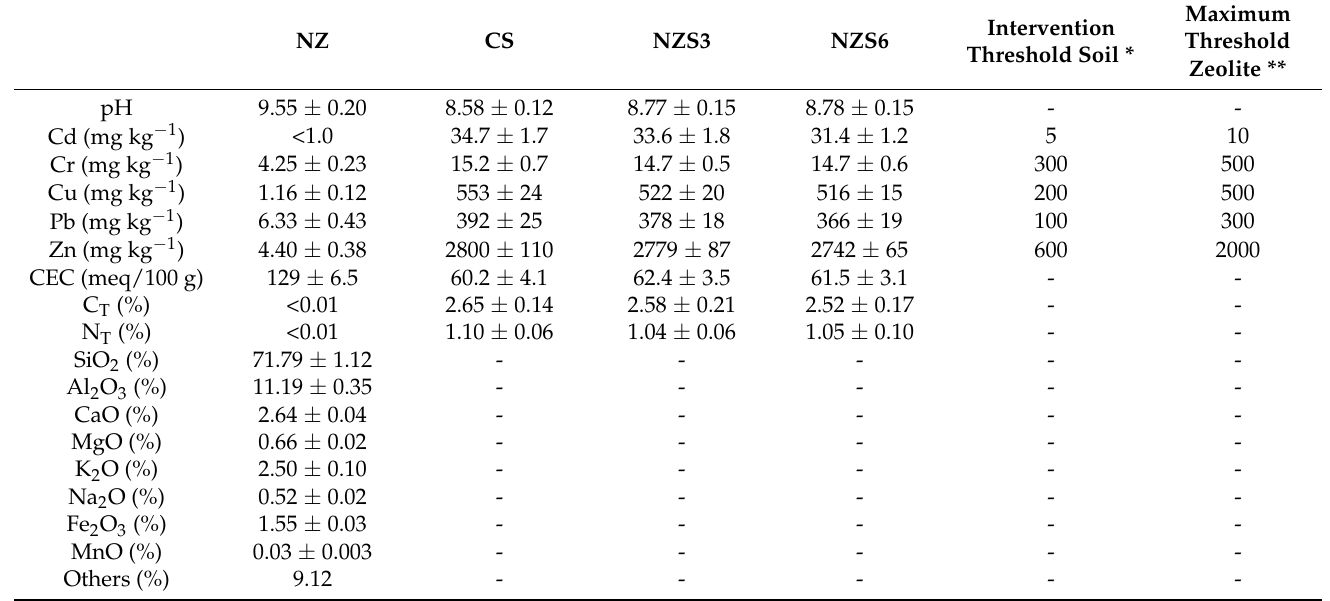
Table 1. Physico-chemical properties of natural zeolite (NZ), control soil (CS) and mixtures with zeolites (NZS3 and NZS6) at the start of experiments (average ± standard deviation, n = 3 parallel